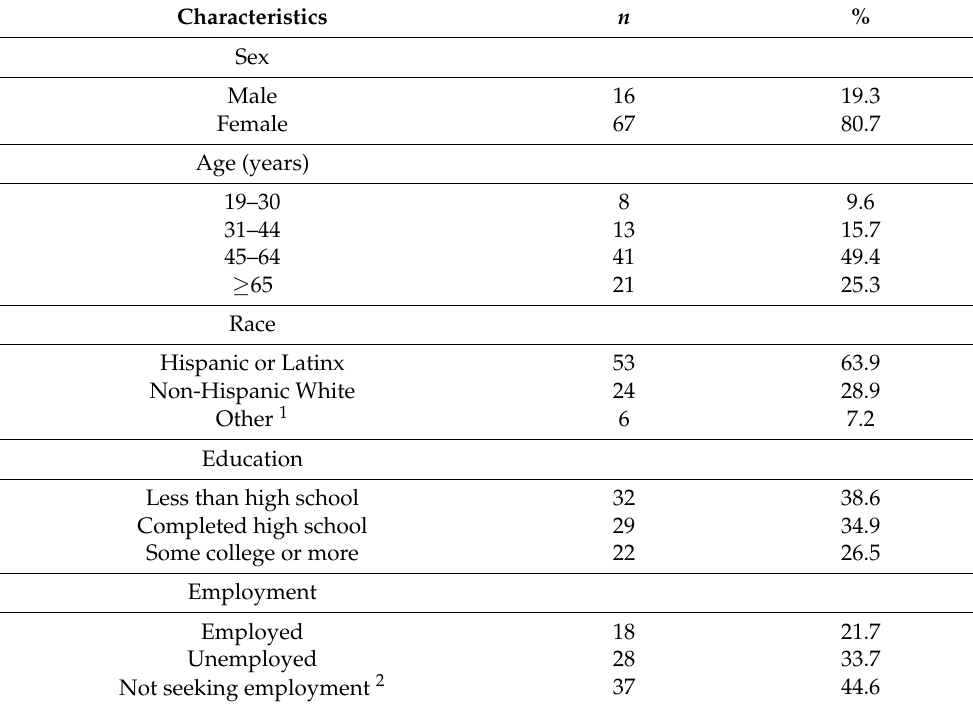
Table 1. General characteristics of study participants recruited from mobile food pantries in Windham County, CT ( n =